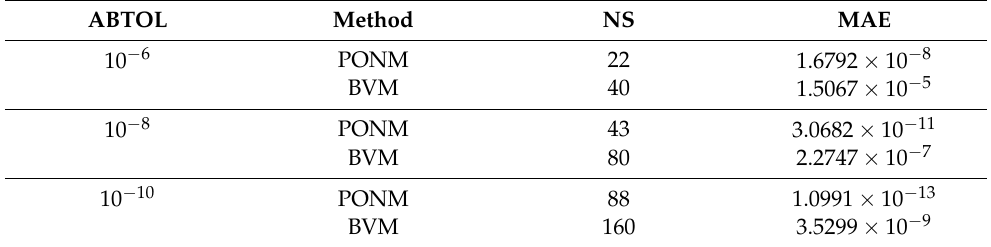
Table 3. Comparison of the numerical results for Problem 6 with x ∈ [ 0,2 π ] .